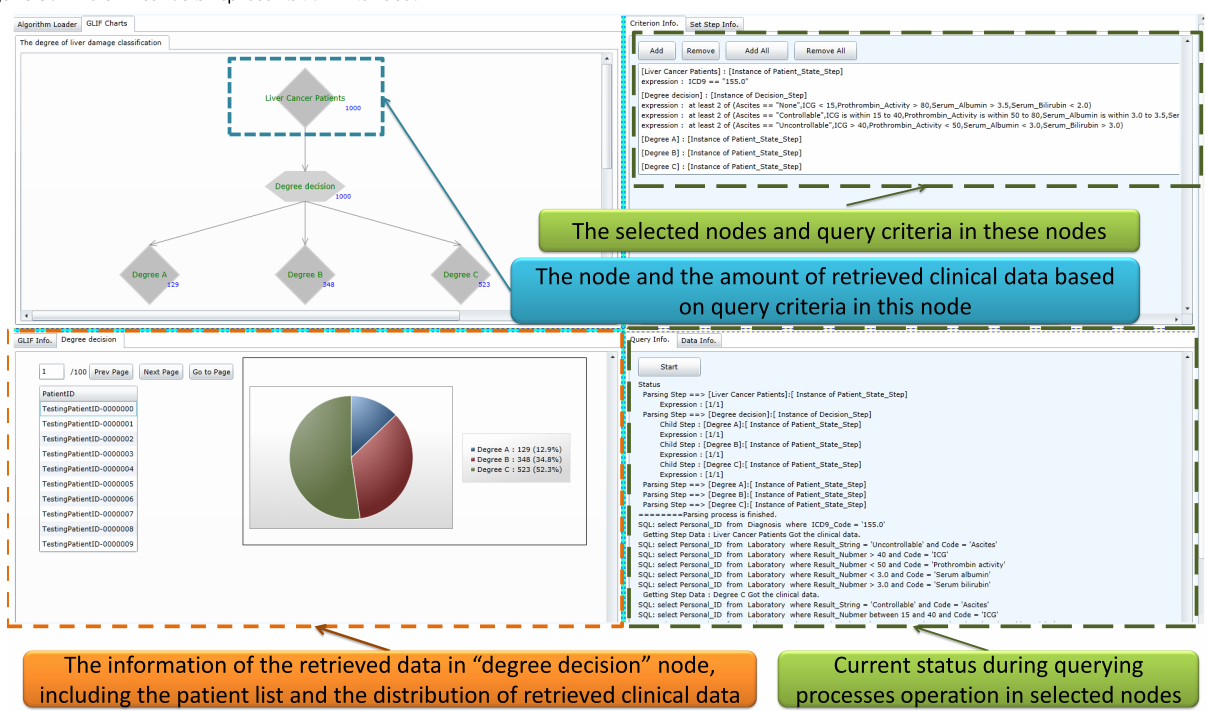
Figure 8. The clinical data representation interface.